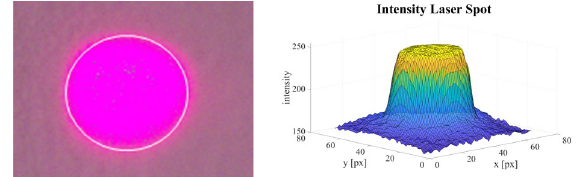
Figure 11. Close-up laser spot with Mamiya ZD camera; left: RGB image with ellipse in white, right: 3D display of the intensities of the red colour channel